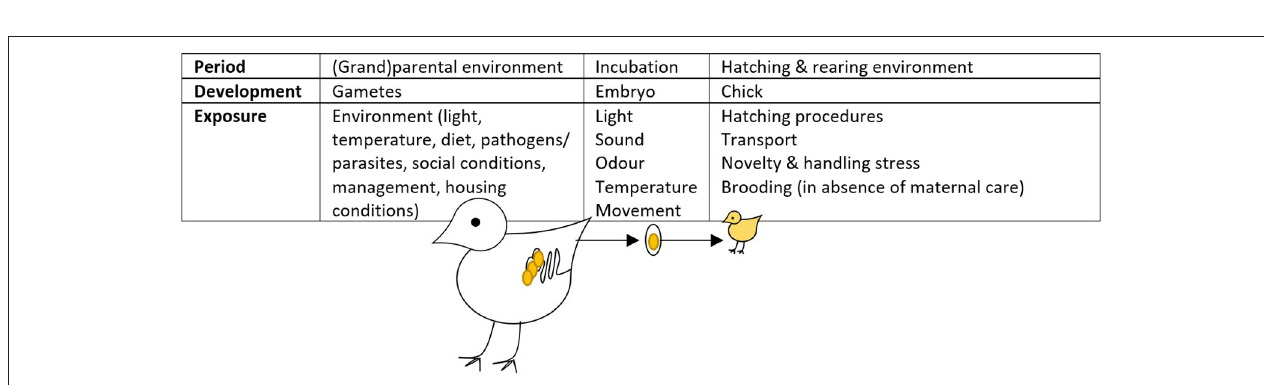
FIGURE 2 | Periods where (embryonic) programming in the commercially-raised laying hen can occur [adapted from (39)]. This figure is amended from Buyse et al. (40) and Geurrero-Bosagna et al. (41).